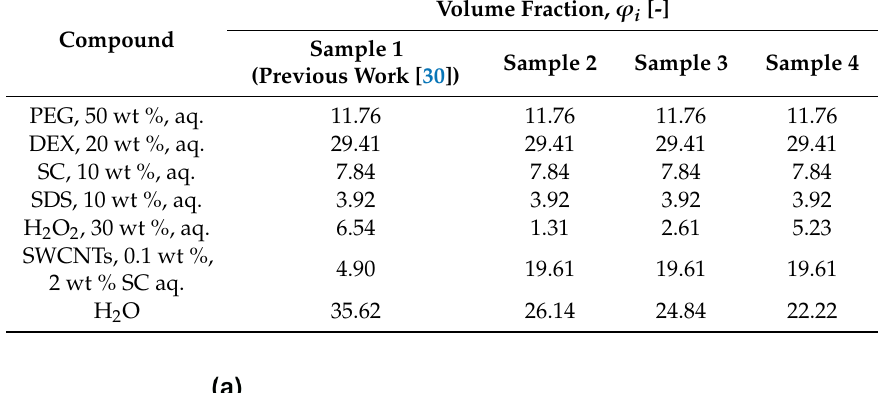
Table 1. Compositions of aqueous two-phase extraction method (ATPE) systems for separation of single-walled carbon nanotubes (SWCNTs) at high concentrations with varying contents of the H 2 O 2 modulator.